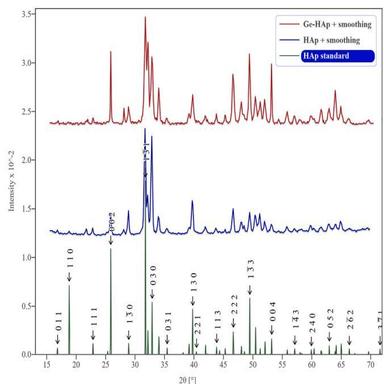
XRD patterns of HAp and Ge-HAp in comparison with the HAp standard.